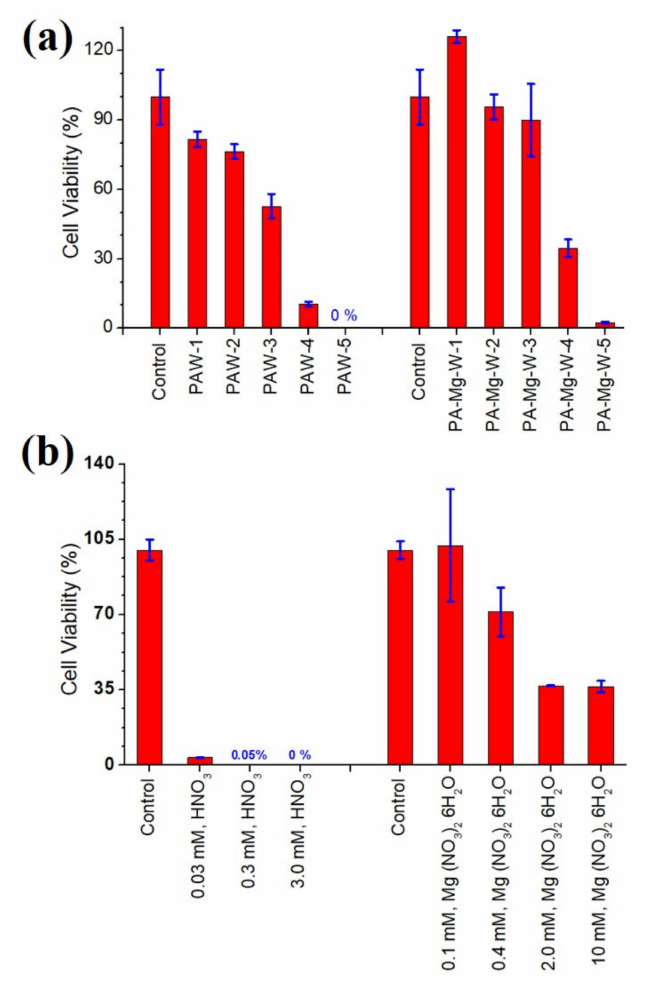
Figure 7. ( a ) Viability of C. pseudolongus cells treated with PAW and PA-Mg-W. The free nitrate ion concentrations were 0.14, 0.69, 3.4, 17, and 86 mM for PAW-1, PAW-2, PAW-3, PAW-4, and PAW-5, respectively. The nitrate salt concentrations were 0.26, 1.3, 6.3, 32, and 160 mM for PA-Mg-W-1, PA-Mg-W-2, PA-Mg-W-3, PA-Mg-W-4, and PA-Mg-W-5, respectively. ( b ) Viability of C. pseudolongus · 6H cells treated with nitric acid (HNO 3 ) and nitrate salt (Mg ( NO 3 ) 2 O ) solutions. The fungal cells 2 were in contact with PAW and reference nitric acid (nitrate salt) solutions for 24